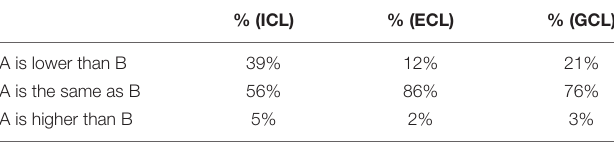
TABLE 4 | Percentage of each option selected by participants for each aspect of cognitive load for (A,B) comparison.